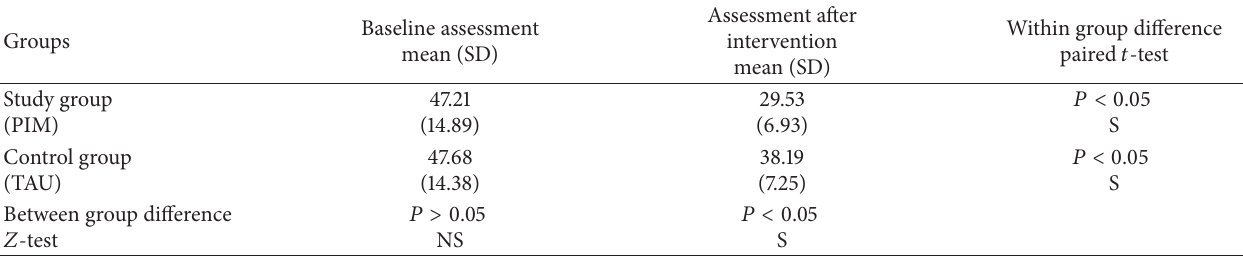
Table 5: Amputees Body Image Scale before and after psychological intervention.